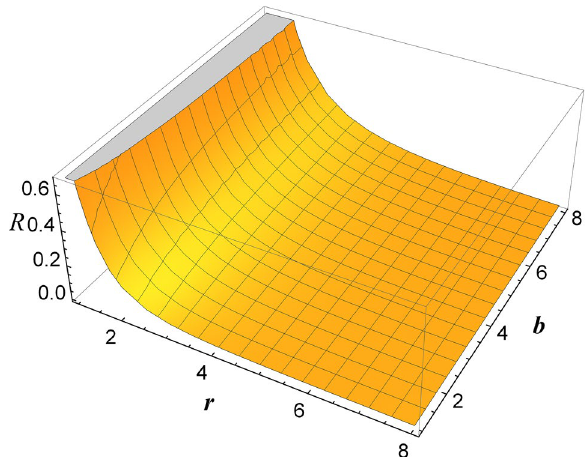
1, 8 1, 8 , and r Bohr radii. ∈ [ ] ∈ [ ]